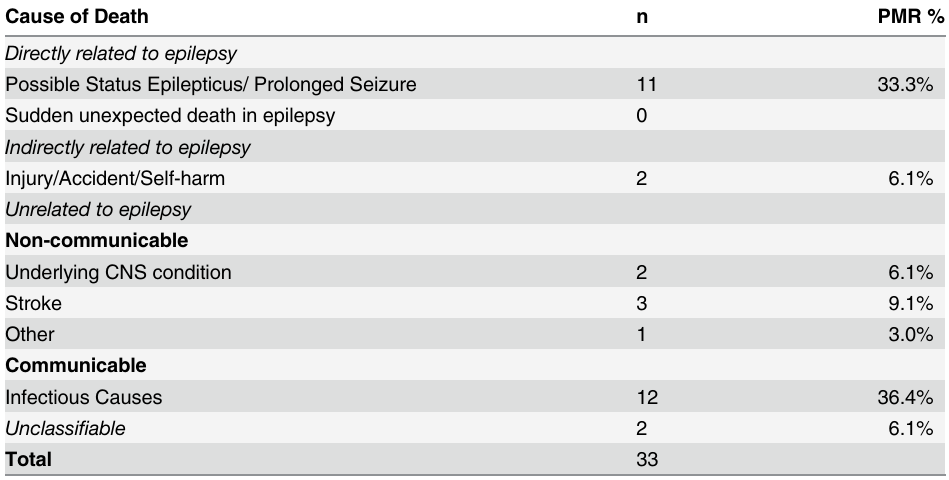
Table 4. Cause of death in people with convulsive epilepsy, Agincourt 2008 – 12. Cause of Death n PMR % Directly related to